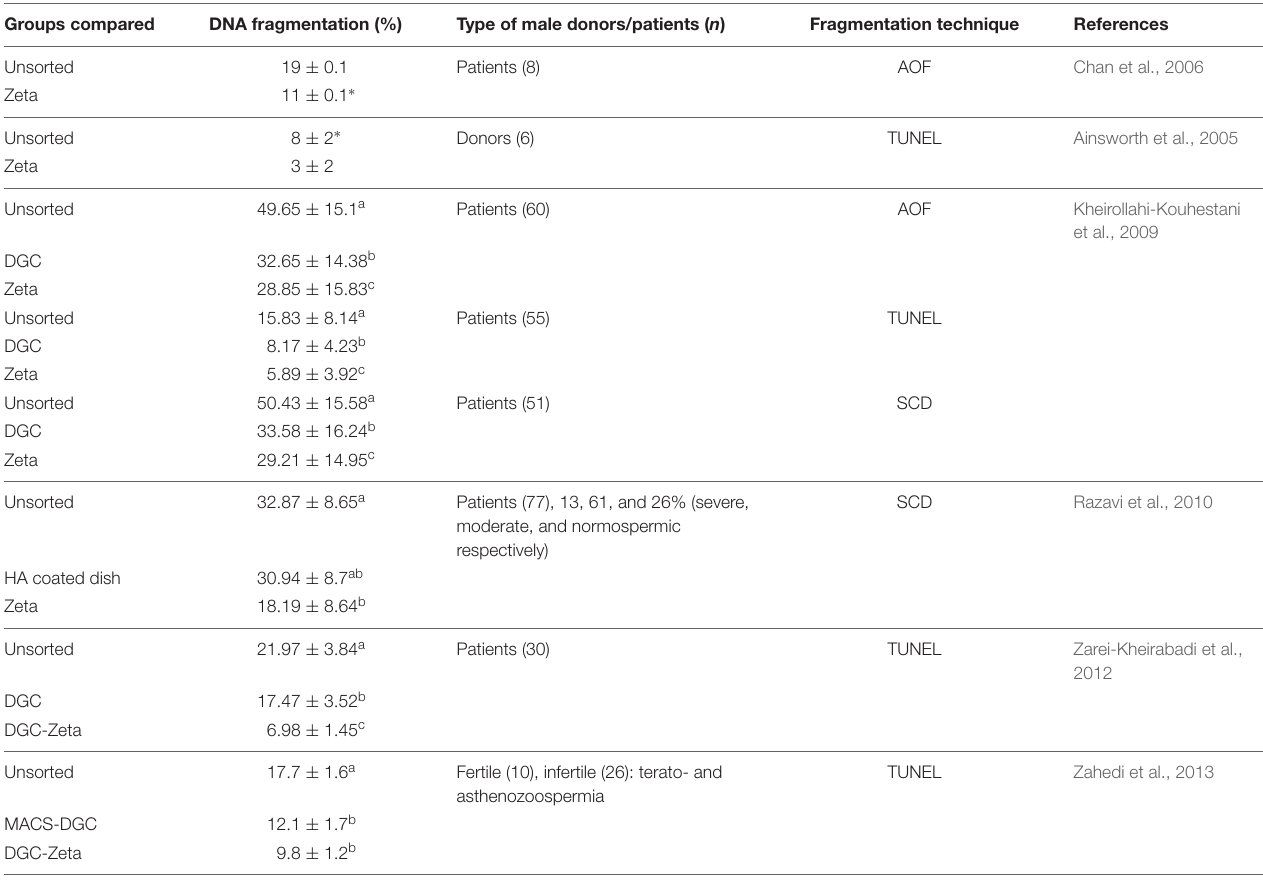
TABLE 5 | DNA fragmentation of spermatozoa selected by Zeta method. Groups